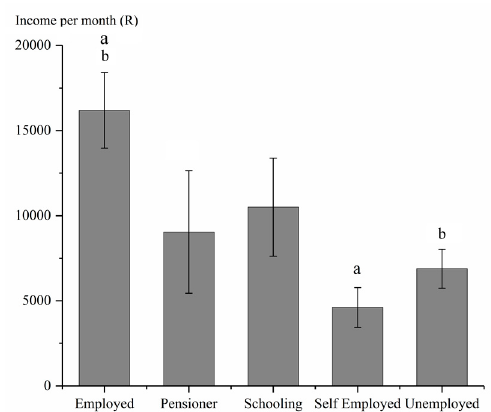
Figure 3. Relationship between income and employment levels in the Nzhelele and Levuvhu river catchments.